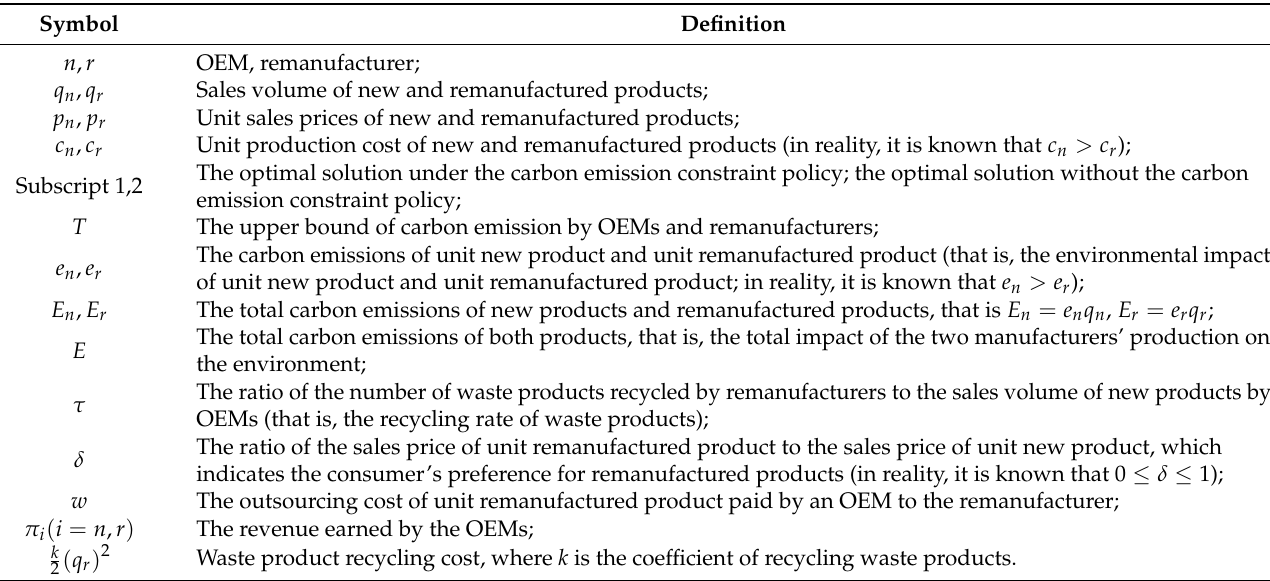
Table 1. Definition of